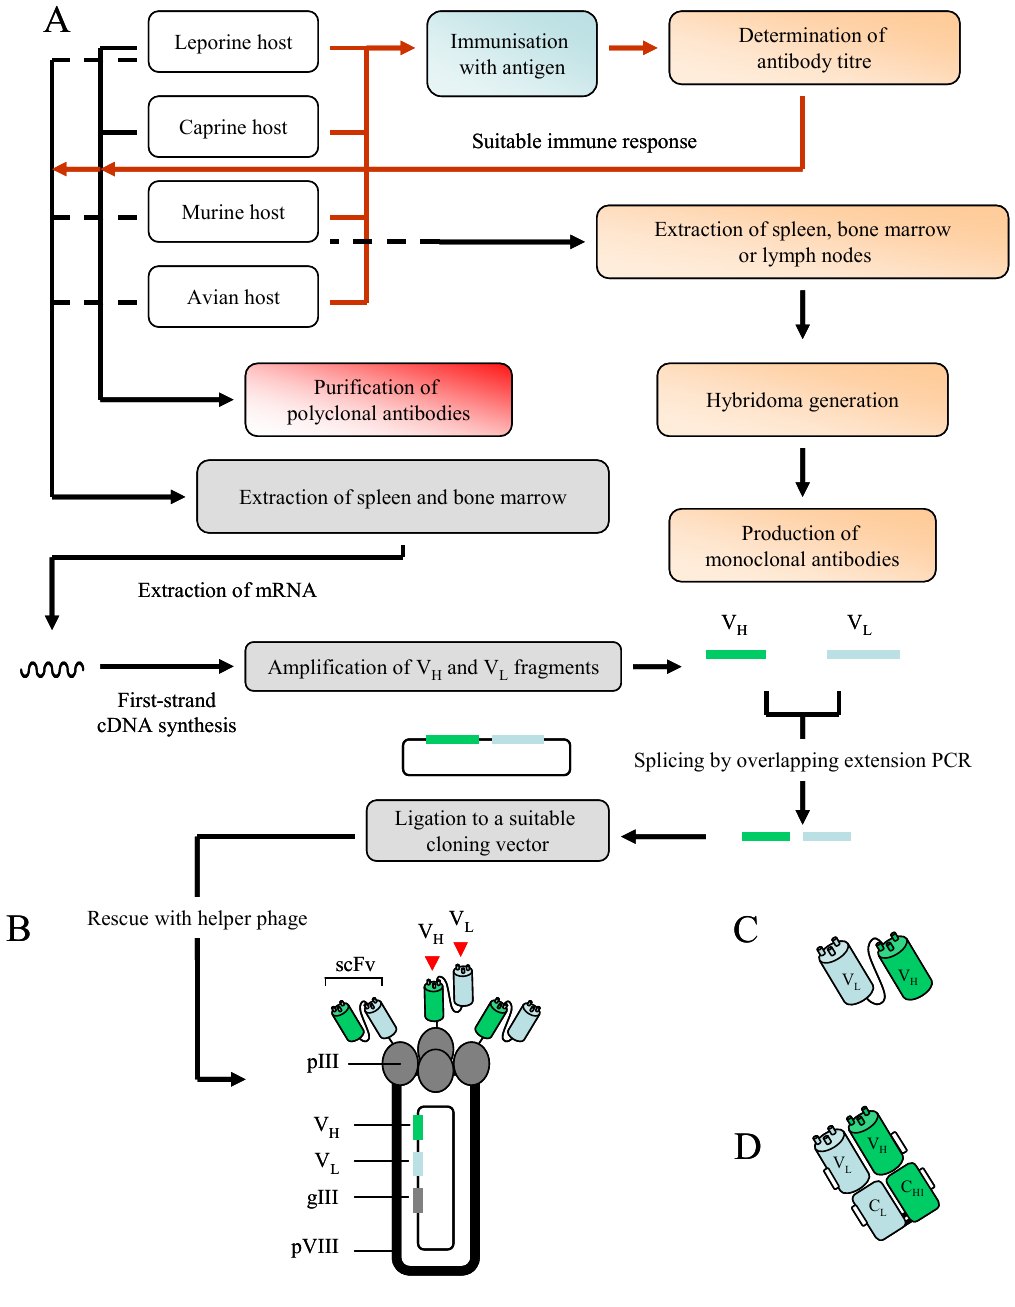
Figure 3. An overview of monoclonal, polyclonal and recombinant antibody production [A]. Immunisation-related stages are represented by a red line, with those involving antibody production shown in black. A more in-depth discussion of the generation